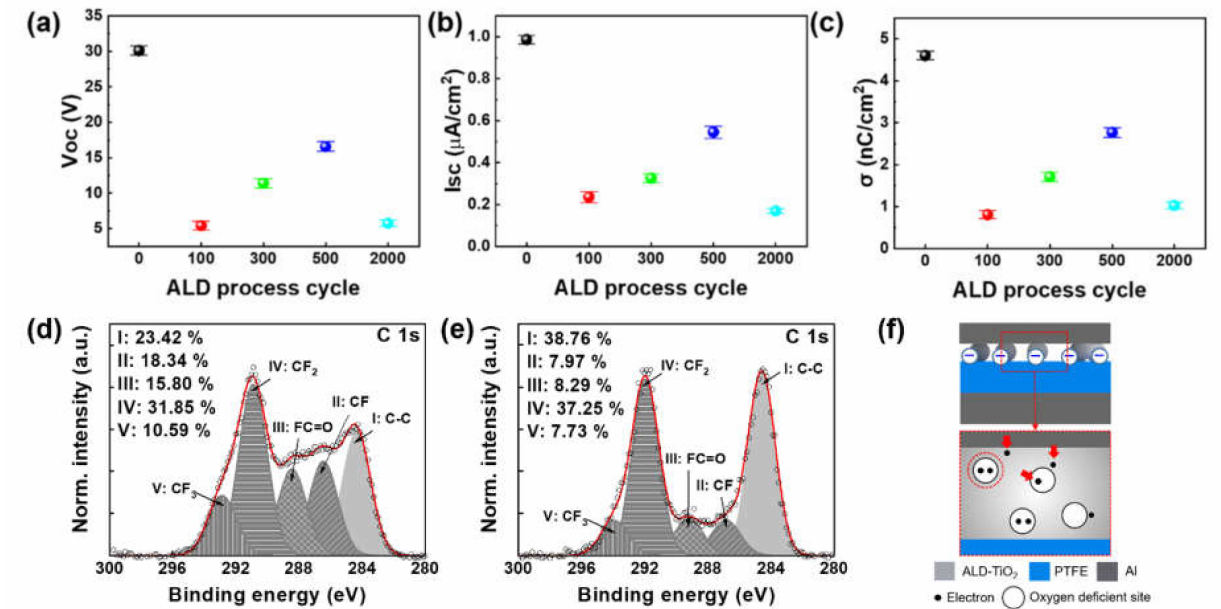
Figure 3. Effects of the ALD-TiO x layer on triboelectric outputs. Changes in ( a ) the open circuit voltage (V OC ), ( b ) short circuit current (I SC ), and ( c ) charge density ( σ ) as a function of ALD cycles. Deconvoluted C 1 s XPS spectra of ( d ) pristine PTFE film and ( e ) 300-TiO x /PTFE film. ( f ) Schematic illustration of the electron trap mechanism according to the oxygen deficient